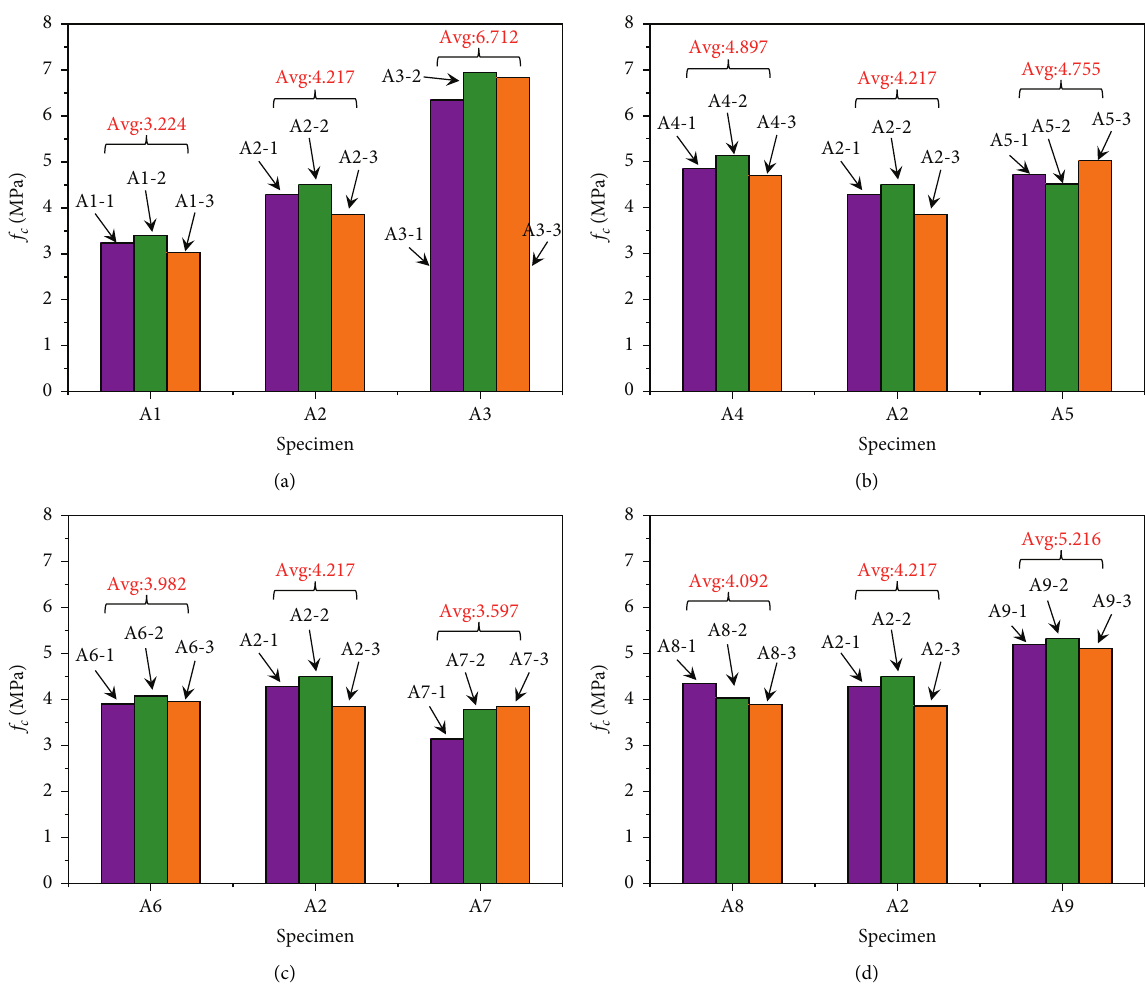
Figure 14: Comparison of peak